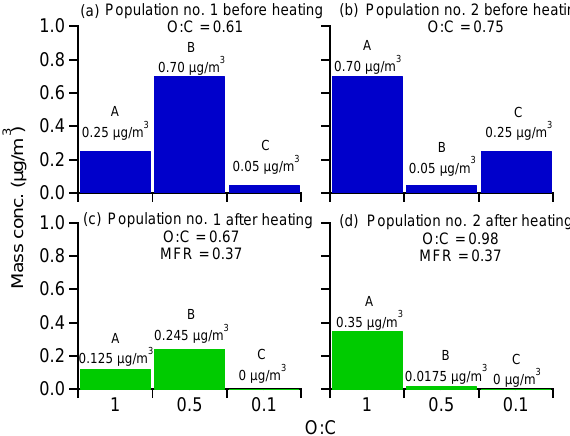
Figure 13. The properties (O:C and volatility) of three model com- pounds and the composition of two populations of particles used in the simple model to illustrate the relationship between bulk OA O:C and volatility. The O:C is 1, 0.5, and 0.1 for compound A, B, and C, respectively. Upon heating at temperature T0, 50, 65, and 100% of A, B, and C would evaporate. Population no. 1 is com- prised of 0.25, 0.7, and 0.05µgm − 3 of A, B, and C, respectively, and population no. 2 is comprised of 0.7, 0.05, and 0.25µgm − 3 of A, B, and C,